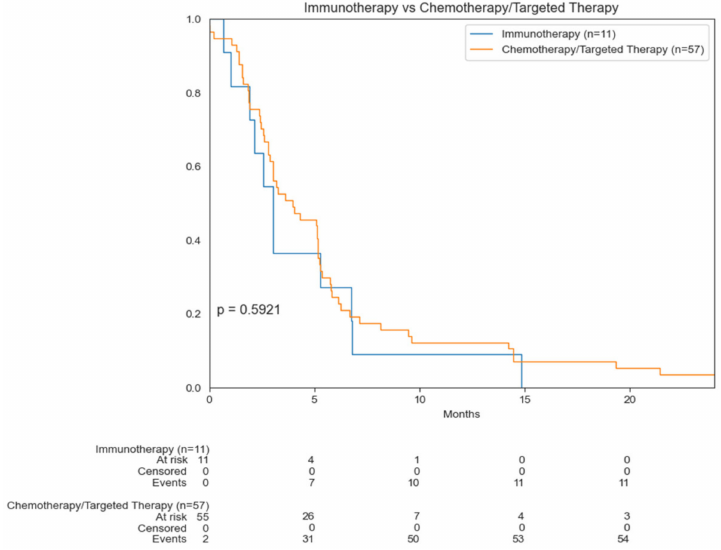
Figure 7. Kaplan–Meier curves comparing OS of immunotherapy versus chemother- apy/targeted